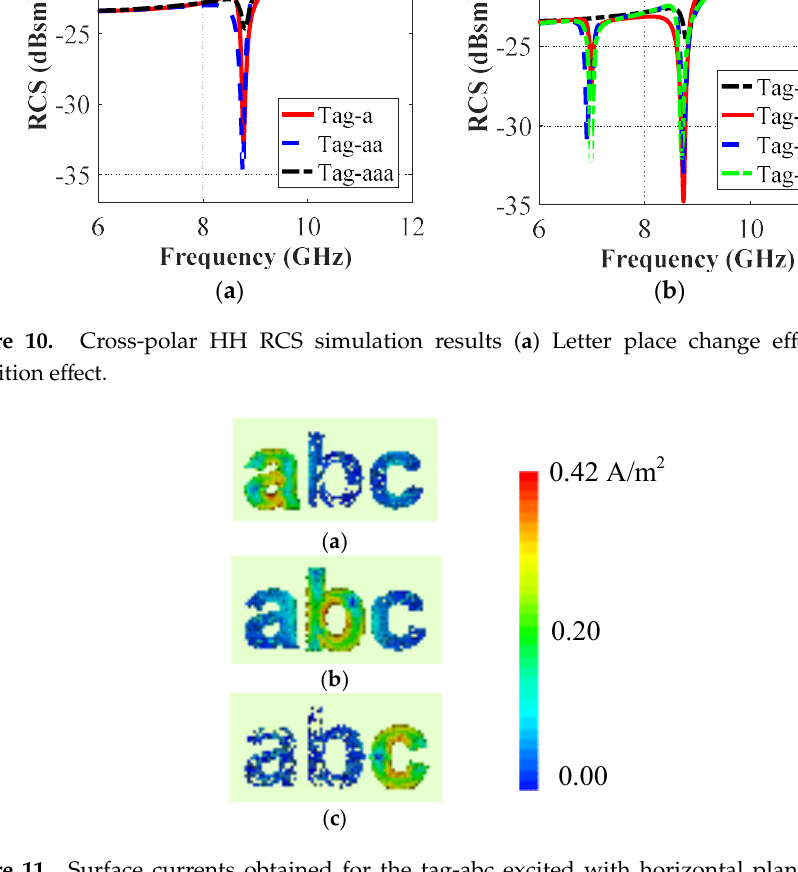
Figure 11. Surface currents obtained for the tag-abc excited with horizontal plane wave: ( a ) at unique frequency signature corresponding to letter ‘a’ i.e., f HH = 8.90 GHz; ( b ) at frequency signature corresponding to letter ‘b’ i.e., f HH = 6.96 GHz, and ( c ) at frequency signature corresponding to letter ‘c’ i.e., f HH = 8.32 GHz.